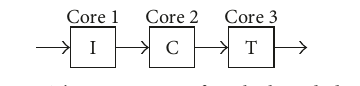
Figure 1: The execution of multithreaded task.